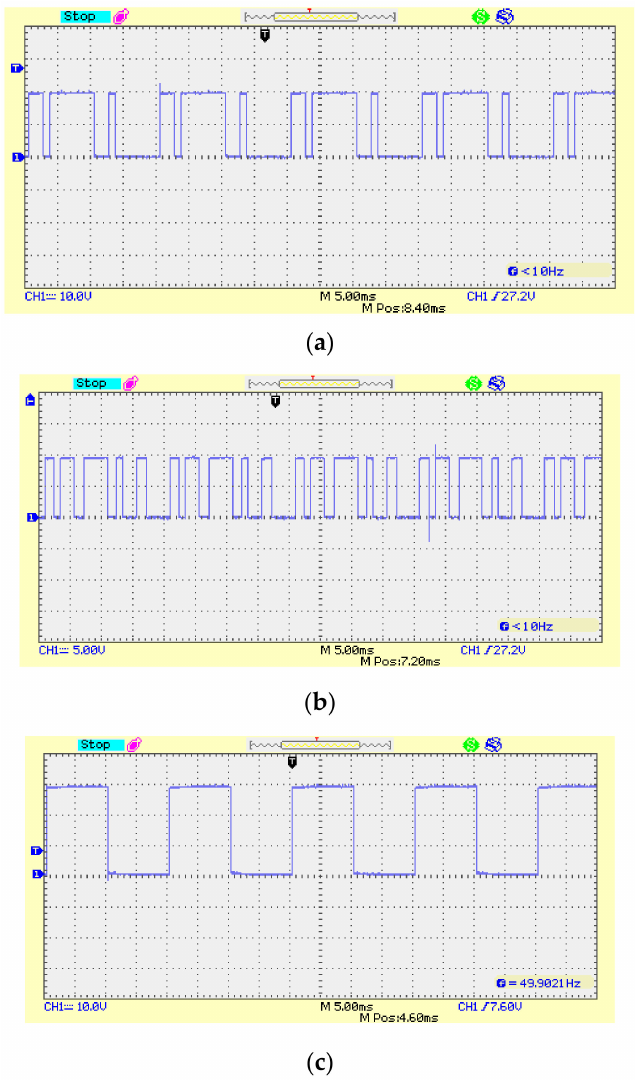
Figure 12. Experimental waveforms of voltage across the switches; ( a ) S a1 ; ( b ) S a3 ; ( c ) S